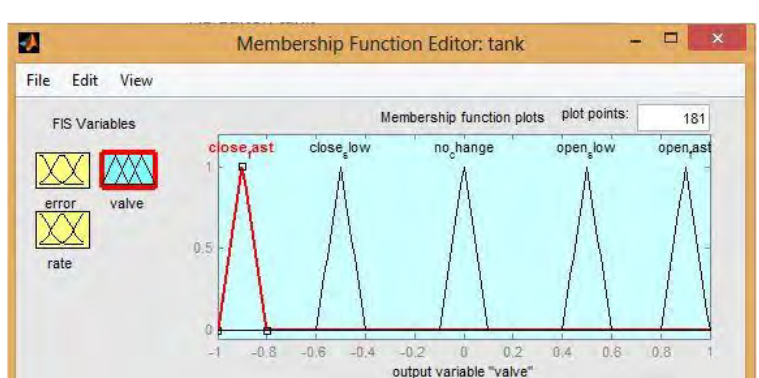
Figure 11. (c) membership of Input flow u(t)